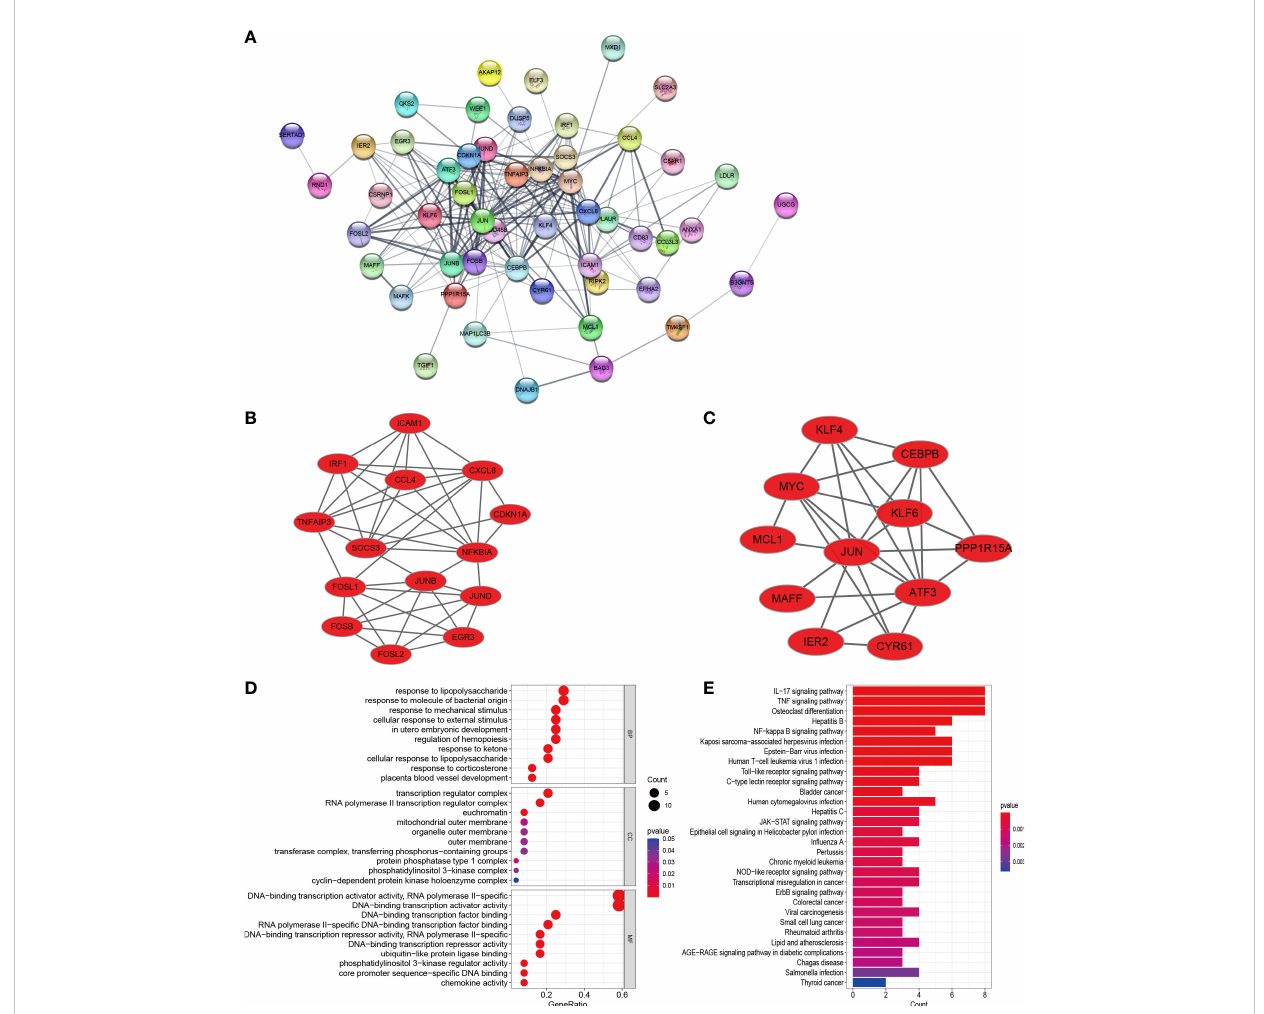
FIGURE 4 PPI network, signi fi cant gene module, and enrichment analysis of the modular genes. (A) Cytoscape network visualization of the 52 nodes and 218 edges based on the STRING online database with an interaction score of > 0.4. The nodes represent genes and the edges represent links between genes. Two key modules were identi fi ed by MCODE and used for network gene clustering identi fi cation. (B) Cluster 1. (C) Cluster 2. (D, E) GO and KEGG enrichment analysis results of the modular genes. p < 0.05 was considered signi fi cant.